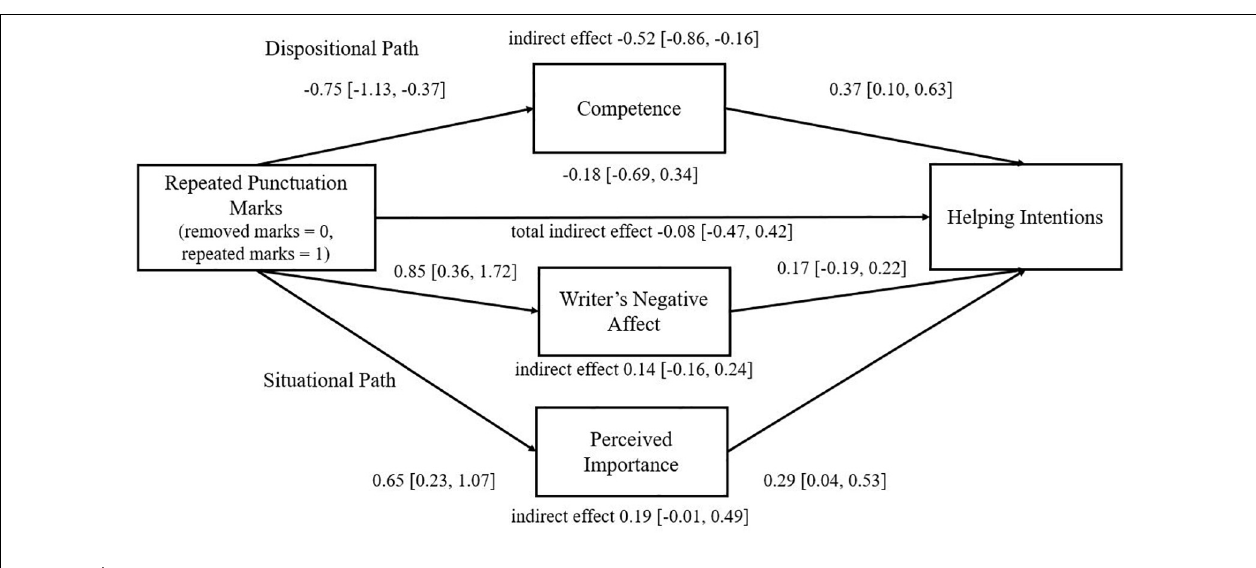
FIGURE 2 | Experiment 2 multiple mediation model of the effect of use of repeated punctuation (vs. control) on helping intentions. N = 92; beta coefficients and confidence intervals are presented based on PROCESS Model 4 (Hayes and Preacher, 2013), controlling for perceived clarity of the message.